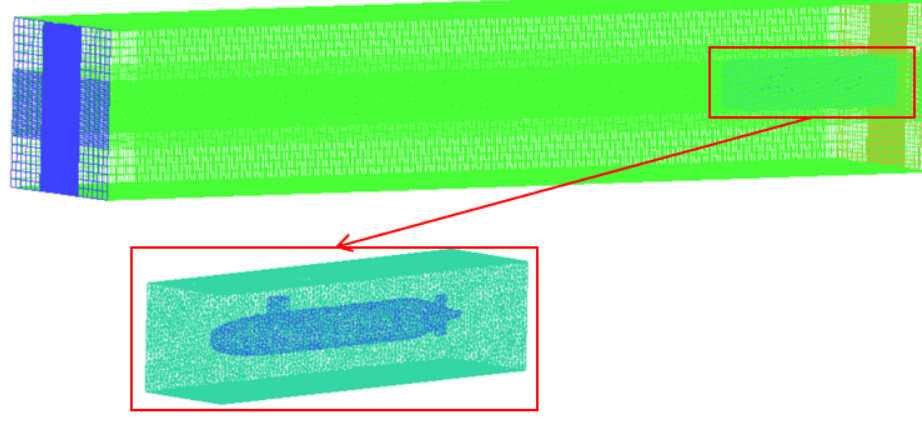
Figure 2. Computing model meshing.